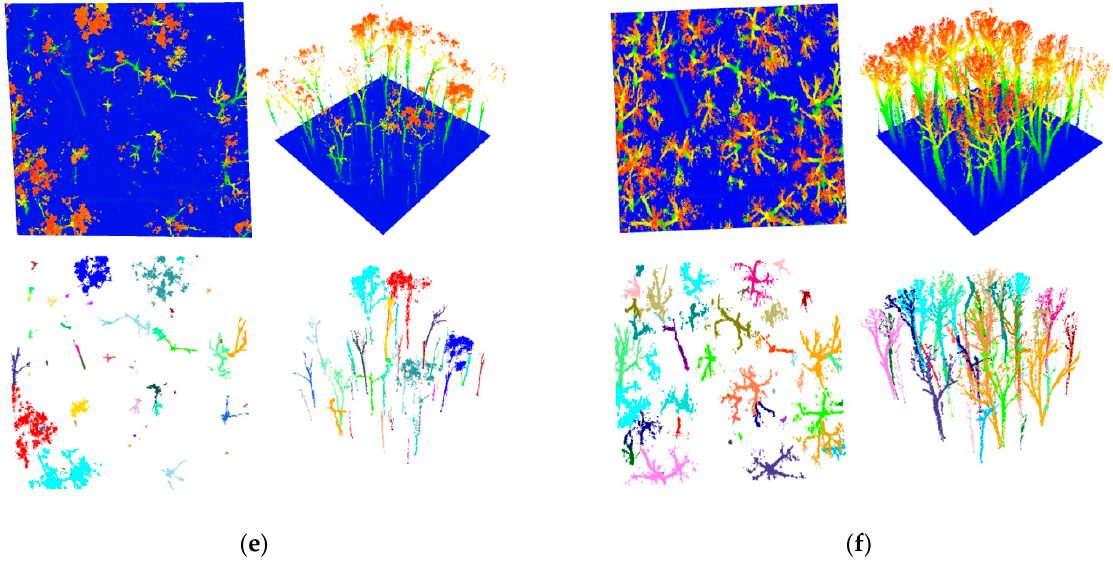
Figure 4. Segmentation results for TLS, Photogrammetric, and LiDAR point clouds. In each tile, the top pair of images are different views of the raw point cloud colored by height and the bottom pair of images show the point cloud classified into individual trees. ( a ) An example of an ‘easy’ TLS plot. ( b ) An example of an ‘intermediate’ TLS plot. ( c ) An example of a ‘difficult’ TLS plot. ( d ) Photo-Plantation dataset. ( e ) Photo-Natural dataset. ( f ) LiDAR-Natural dataset.